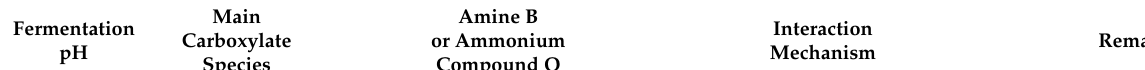
Table 1. Adsorption characteristics and possible interactions between carboxylic acids (HA)/carboxylate (A − ) and amine base (B)/ammonium compounds (Q). X − is an inorganic anion. Reproduced with permission from [55], published by Elsevier,